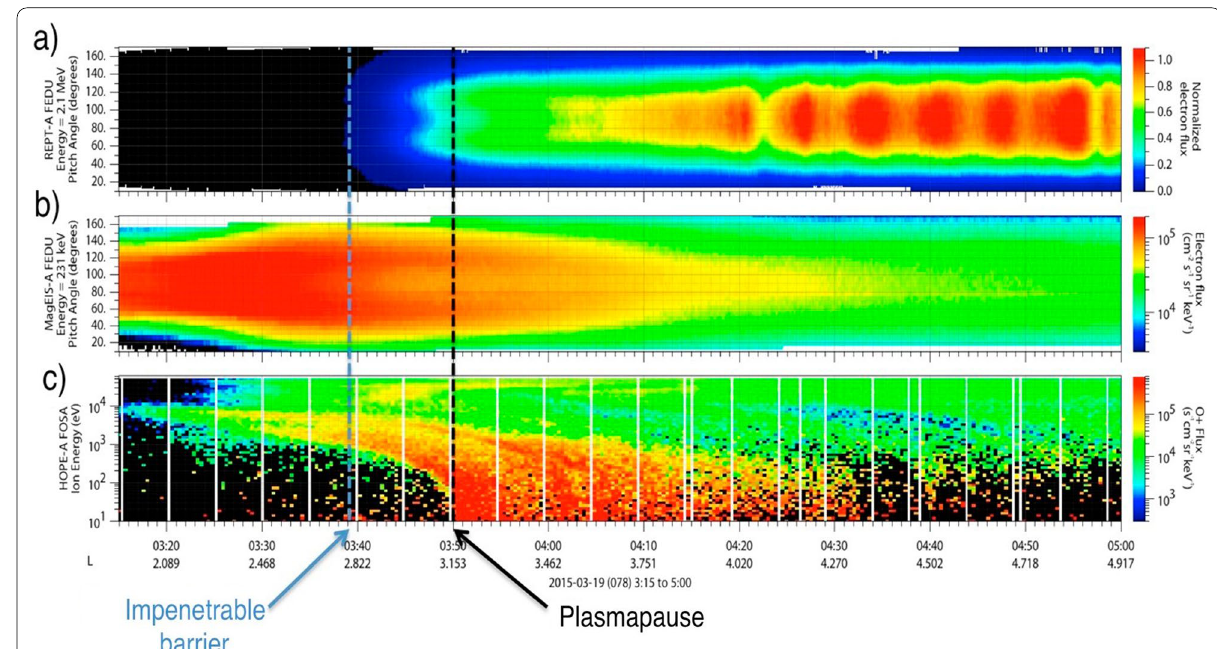
Fig. 6 Van Allen Probe-A data for 19 March 2015, 0315–0500 UT. a Pitch angle distributions for 2.1 MeV electrons from 1.5 ≲ L ≲ 5. b Pitch angle distributions for 231 keV electrons. c Spin-averaged low-energy oxygen energy spectrogram (From Baker et al.